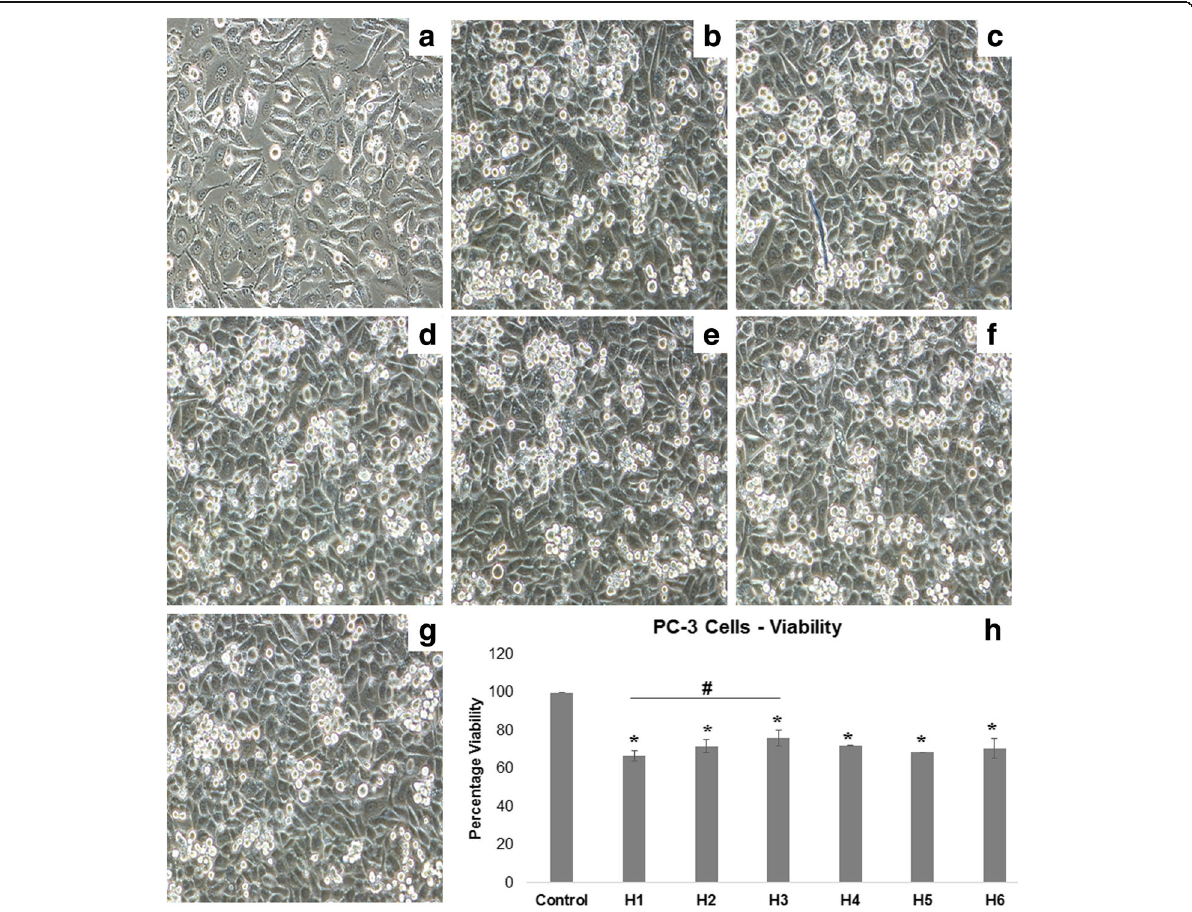
Fig. 4 Viability of PC-3 cells after 24-h incubation with honey. a Untreated Control, b H1, c H2, d H3, e H4, f H5, g H6. Cell under 20X magnifica- tion. h Percentage decrease in viability of cells after 24-h incubation with honey varieties. *Treatment groups shows significant lowering of viabil- ity compared to control. # - Significant difference between H1 and